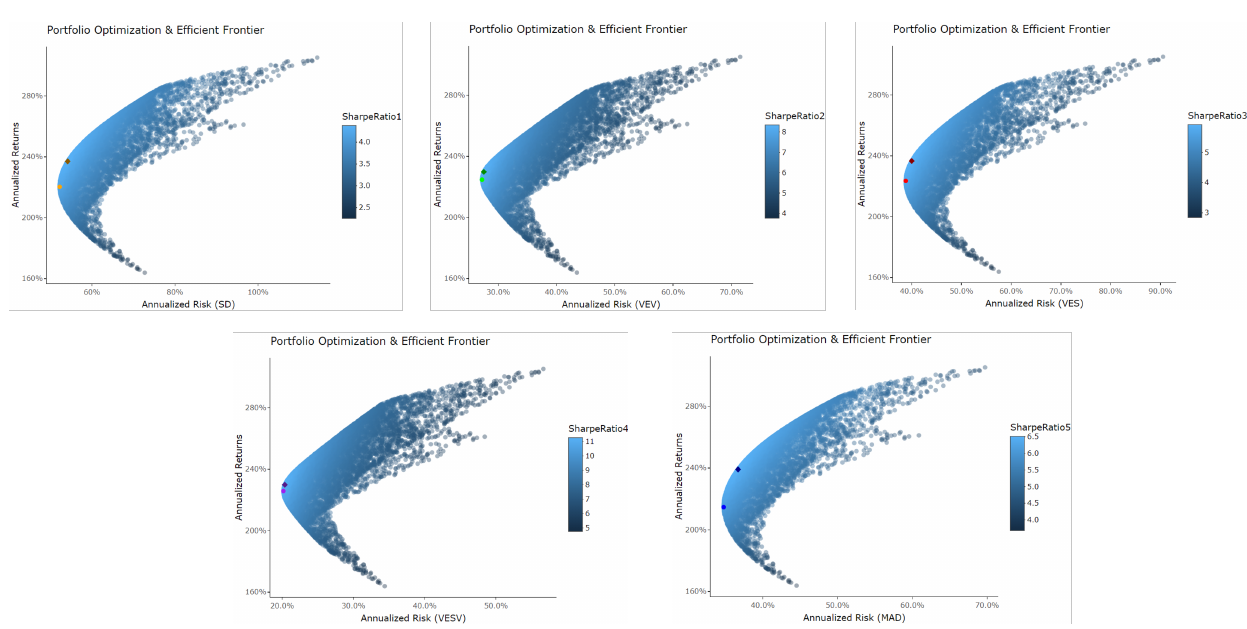
Figure 13. Efficient frontiers of Stocks.